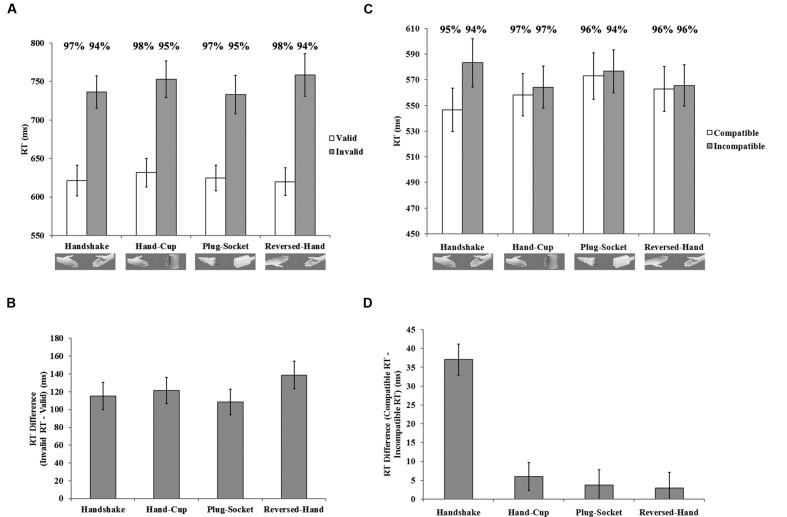
Results of Experiment 4. Results of Experiment 3. (A) and (B) respectively, depict the mean RT and RT difference between the invalid and valid trials for the cueing task. (C) and (D) respectively, depict the mean RT and RT difference between the compatible and incompatible trials for the interference task. Error bars indicate standard errors. Mean accuracy rates for every condition was shown above the corresponding bars.